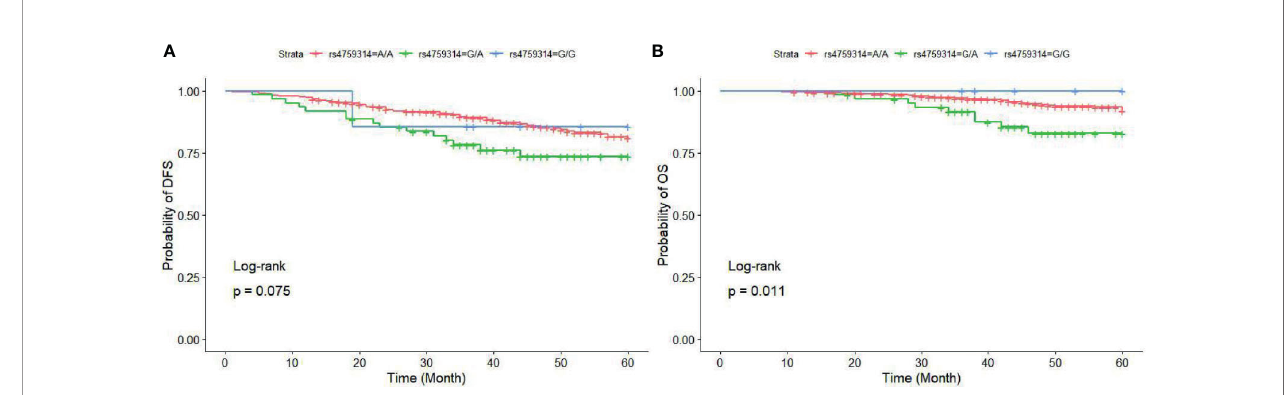
FIGURE 3 | DFS (A) and OS (B) for BC patients with different genotypes of HOTAIR rs4759314. BC, breast cancer; HOTAIR , HOX transcript antisense RNA; DFS, disease-free survival; OS, overall survival. The overall three curves of DFS are insigni fi cant different (P = 0.075), however, subjects with GA genotype had a worst DFS than subjects with AA genotype(P = 0.026); the overall three curves of OS are statistically signi fi cant, subjects with GA genotype had a worst OS in the three genotypes, however, subjects with GG genotype and AA genotype had a similar OS.